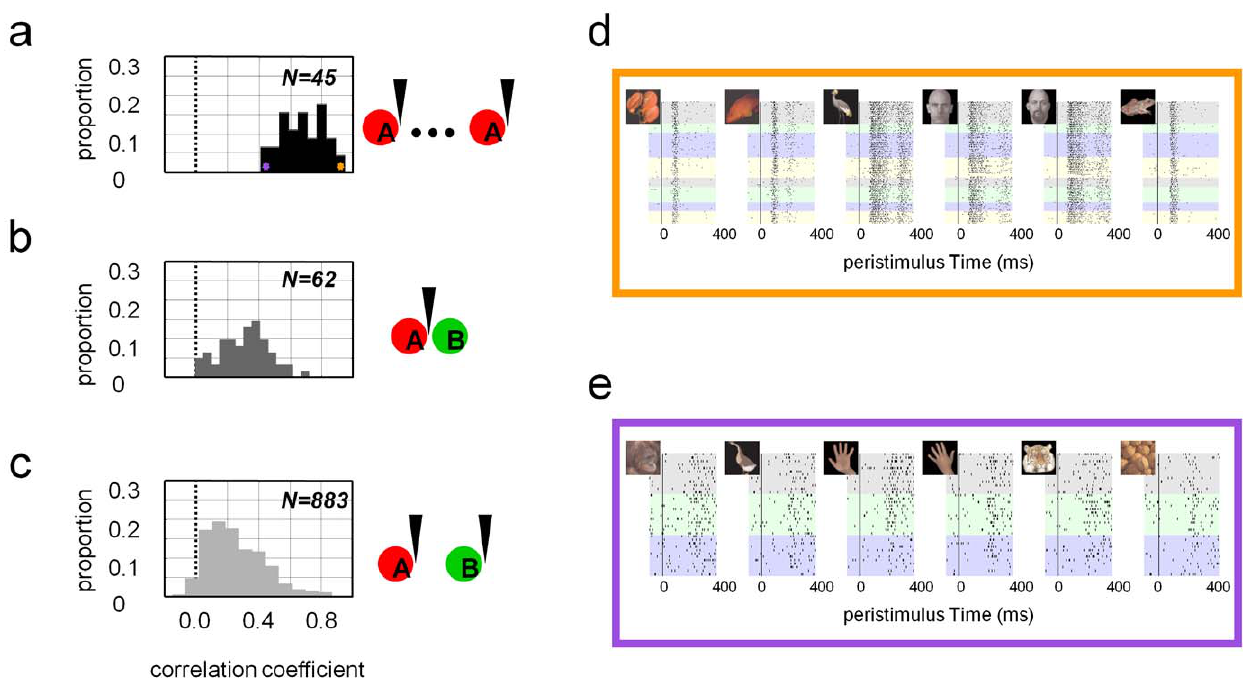
Figure 6. Evaluation of stability over the population of recorded neurons. A correlation-based similarity index (CSI) was used to characterize the similarity of the selective responses between the same neuron measured in the first and last recording sessions from the same electrode (a), between different neurons measured simultaneously on the same electrode (b), and between different neurons measured simultaneously on different electrodes (c). In the last case, only neurons for which spike waveforms were successfully maintained over at least 2 sessions were considered. Panels (d) and (e) show two neurons with the highest and lowest CSI between sessions, corresponding to the orange and purple dots in (a),